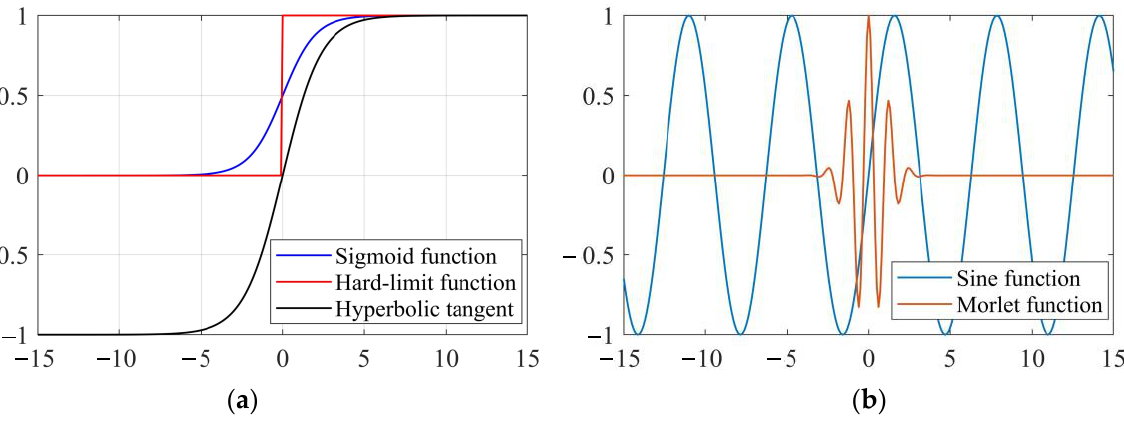
Figure 7. Demonstration of five investigated activation functions: ( a ) sigmoid function, hard - limit function, and hyperbolic tangent function; ( b ) sine function and Morlet wavelet function.